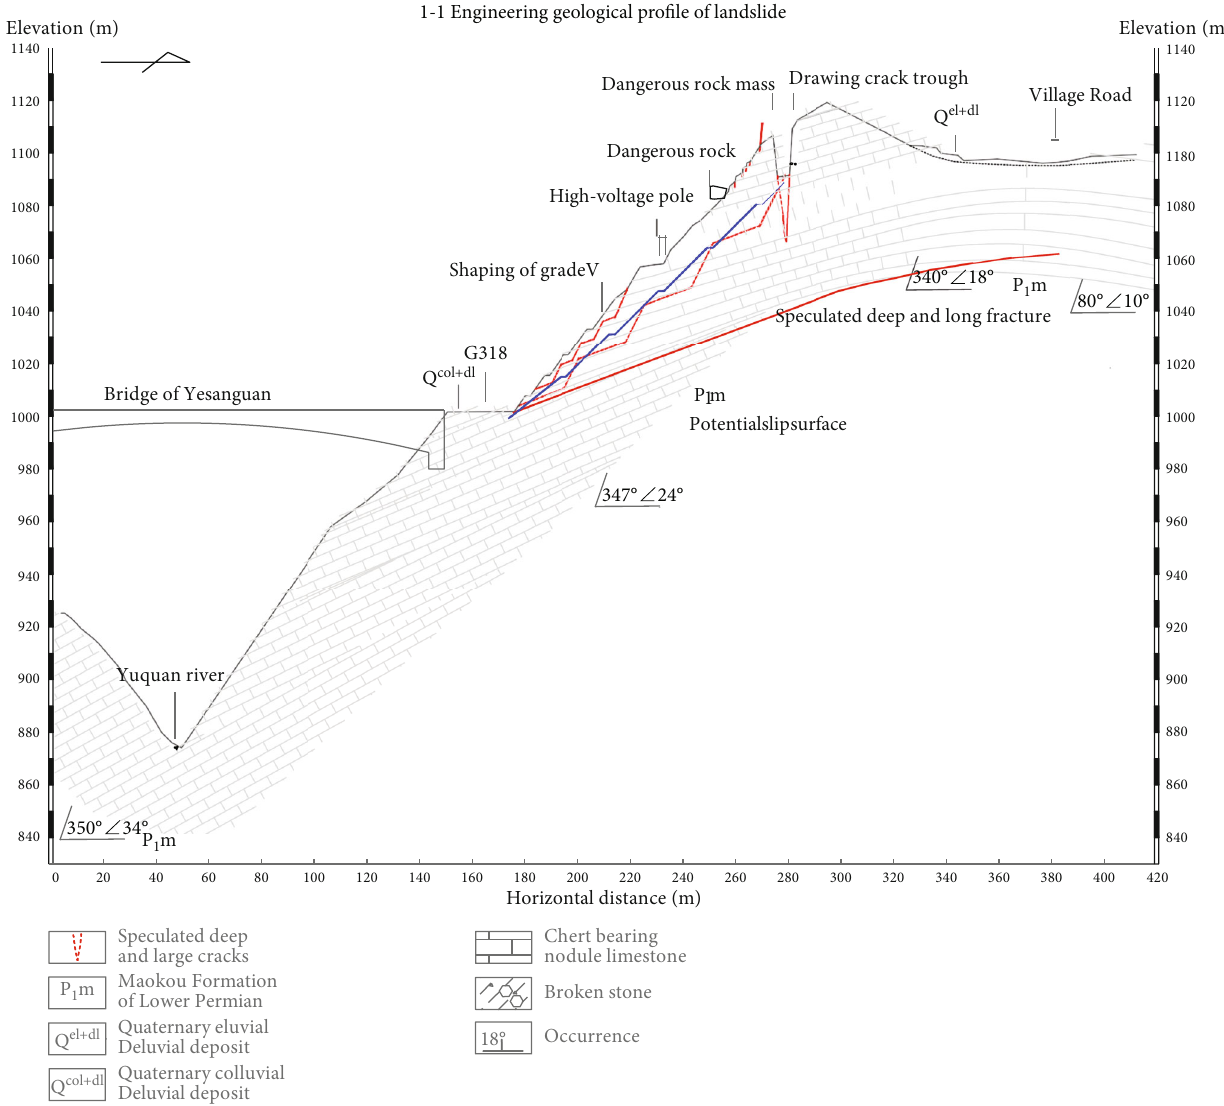
Figure 13: Schematic diagram of 1-1 ′ section slope